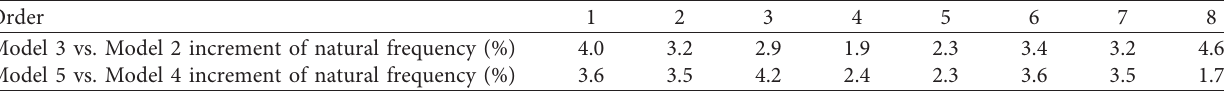
Table 6: The influence of the number of auxiliary piers on the natural frequency of cable-stayed bridges.